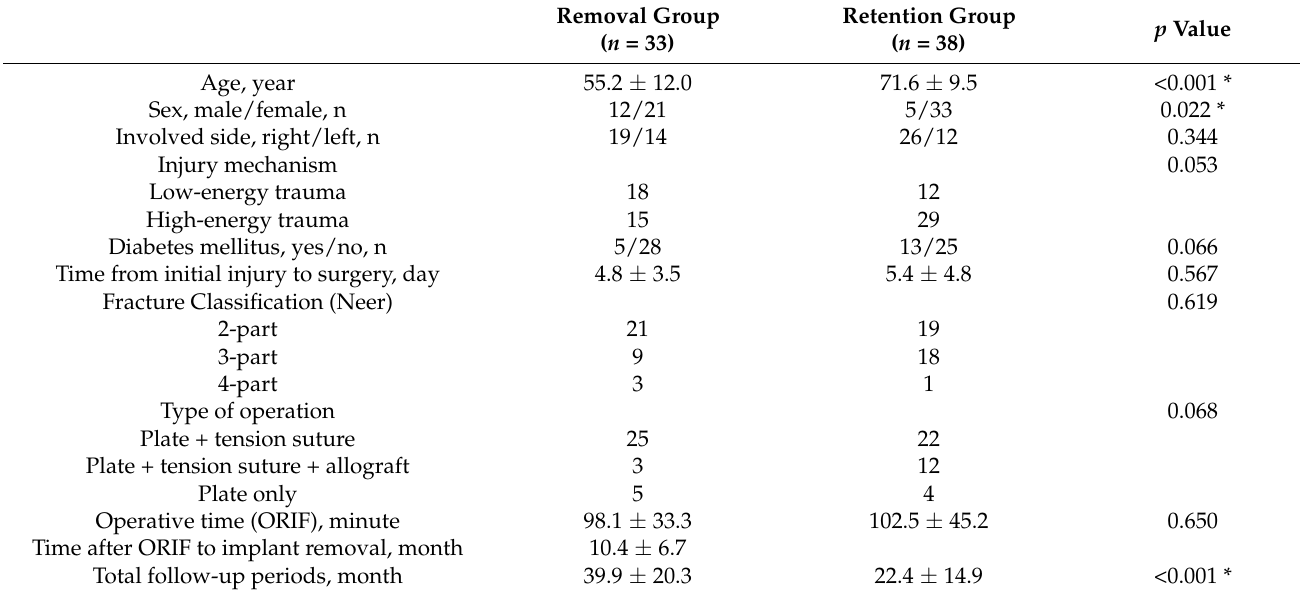
Table 1. Demographic factors of device removal and retention groups.